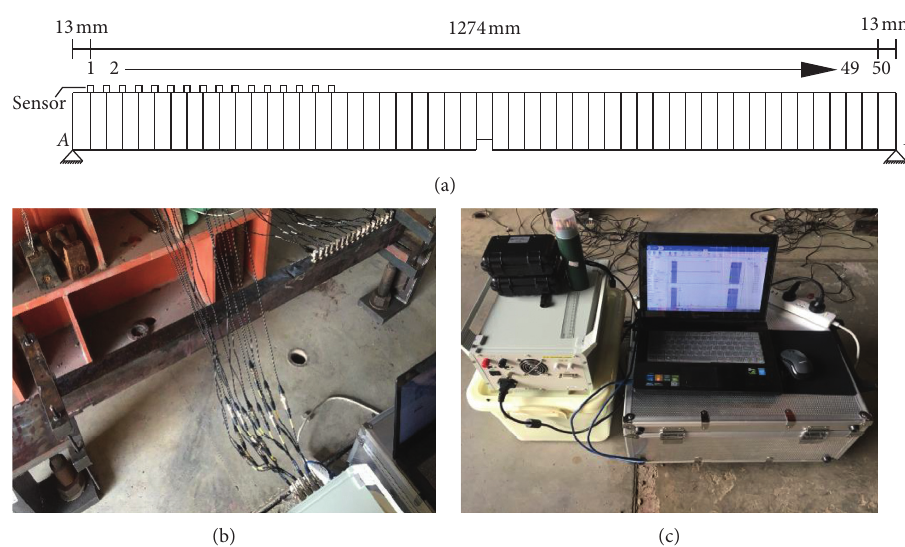
Figure 28: Experimental device layout. (a) Sensor layout. (b) Experimental beam. (c) Experimental equipment.